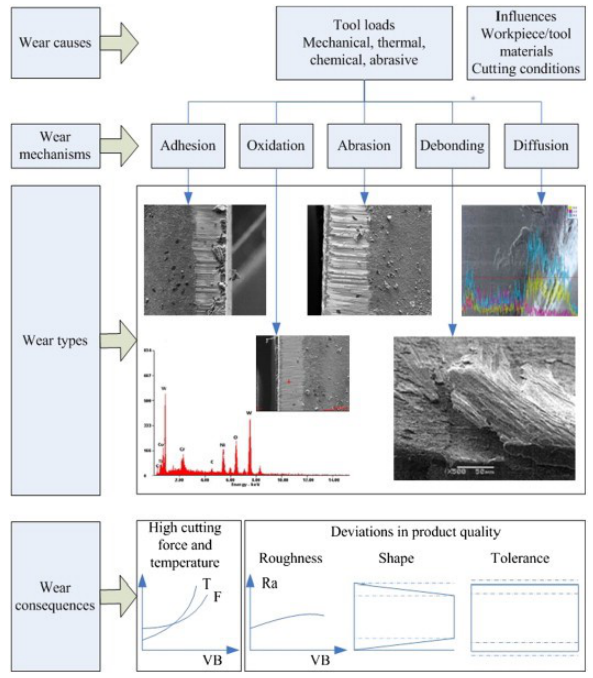
Figure 2: A summary of causes, mechanisms, types and conse- quences of tool wear in nickel based superalloy cutting